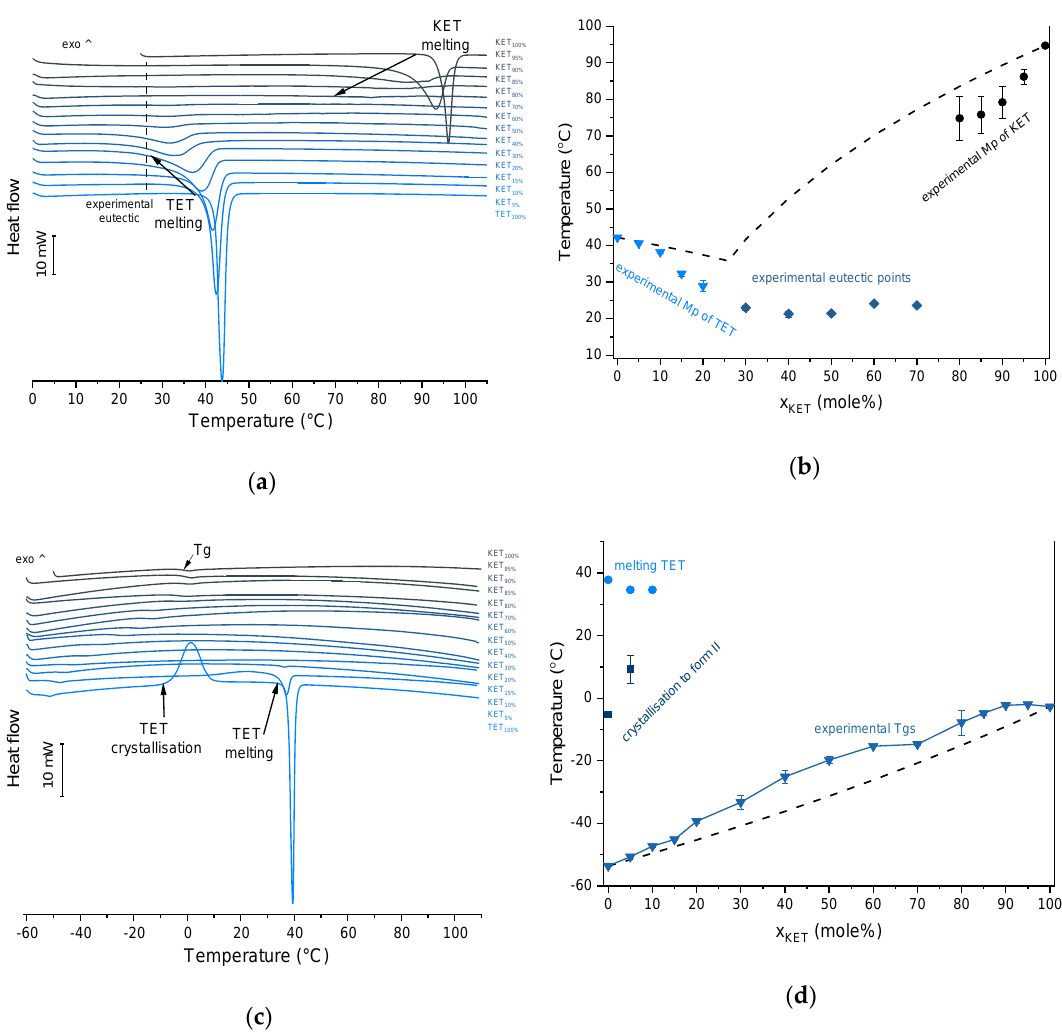
Figure 6. Thermal analysis of KET-TET systems: ( a ) DSC thermograms from first heating; the broken line indicates the position of the eutectic peak while the arrows show the position of the melting peaks, ( b ) phase diagram based on thermal analysis of first DSC heating; the broken lines show the theoretical liquidus curves calculated using Equation (1), ( c ) DSC thermograms from second heating (the samples were first heated 110 ◦ C at 10 ◦ C / min, quench cooled at a nominal cooling rate of 300 ◦ C / min and reheated at 10 ◦ C / min) ( d ) phase diagram based on thermal analysis of second DSC heating; the broken line shows the theoretical Tg values calculated using Equation (2). For plots (a) and (c) the subscript indicates the content of the named component in mole%.